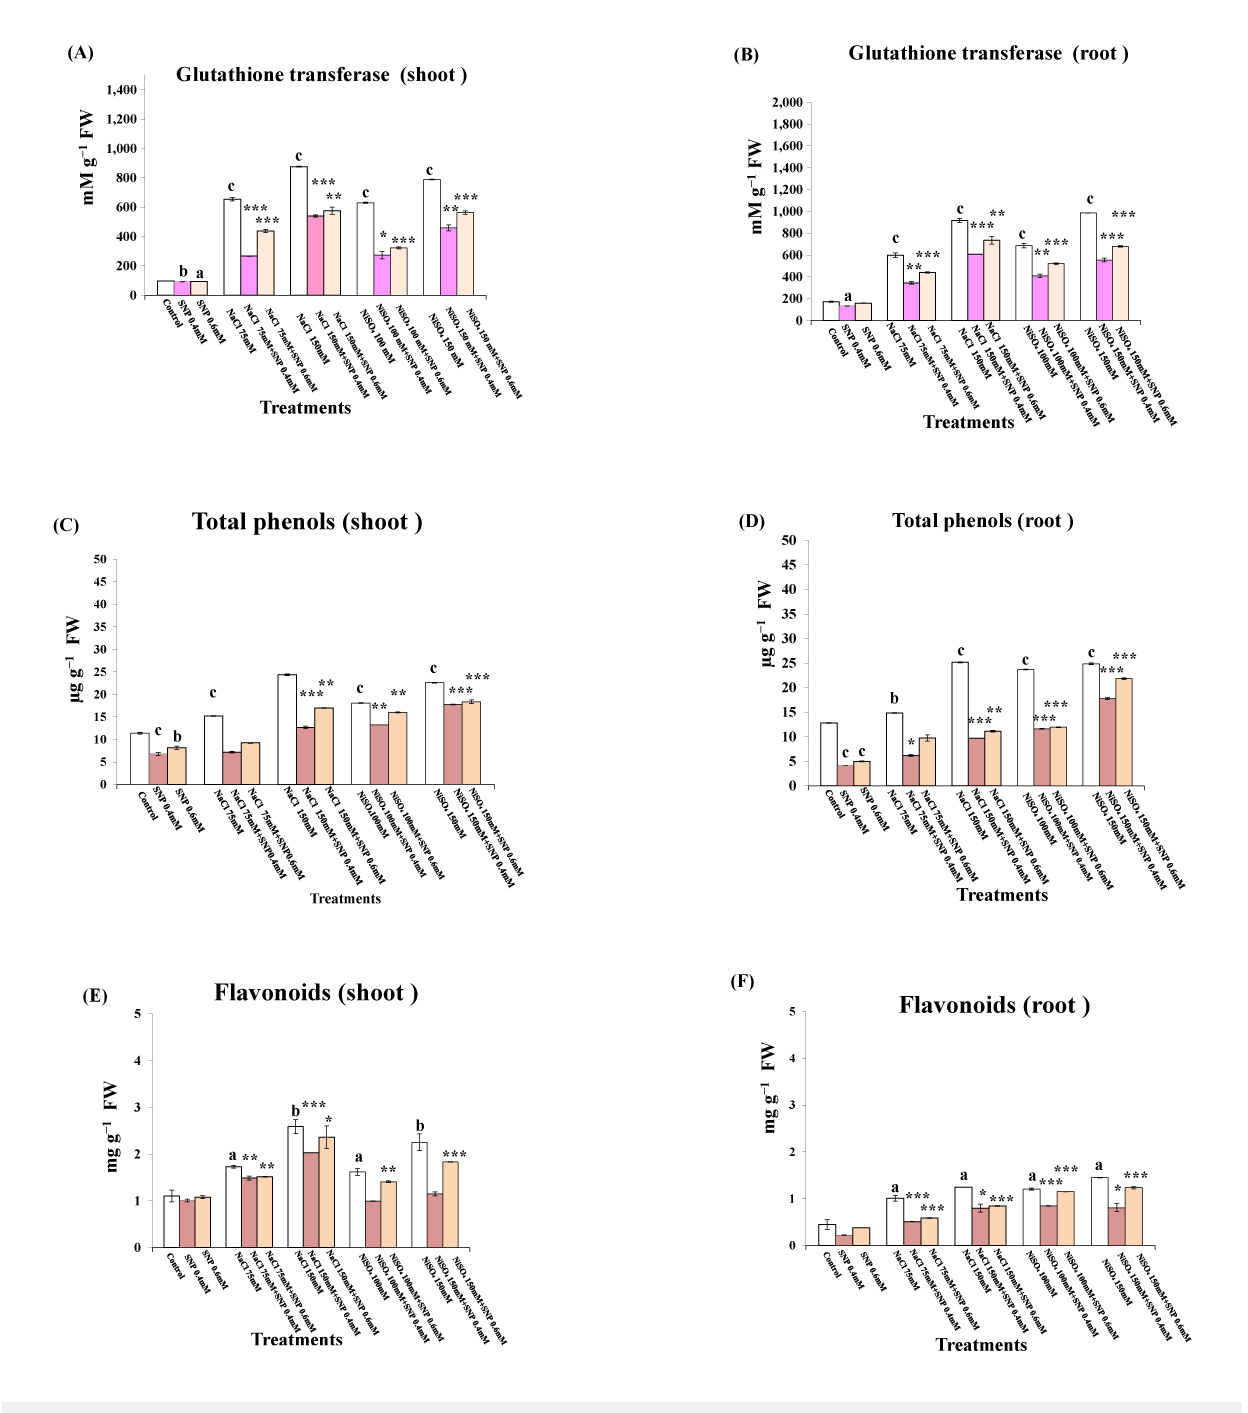
Figure 2 Effect of sodium nitroprusside (SNP) (as nitric oxide donor) on glutathione transferase activity, total phenolics and flavonoids contents of Lupinus albus subsp. termis (Forssk.) Ponert, under sodium chloride (0, 75, and 150 mM) and Ni stress (0, − 1 100, and 150 mM). The results of total phenolics and flavonoids are expressed in µ g g fresh weight. Data are mean ± SE (standard error) offive replicates. Values with letters are significantly different from the control (tap water). Letter “a” at p < 0.05 (significant), “b” at p < 0.01 (highly significant), “c” at p < 0.001 (extremely significant), and no letter = nonsignificant. Values with asterisks are significantly different from the SNP control (0.4 mM, 0.6 mM). Asterisks * at p < 0.05 (significant), ** at p < 0.01 (highly significant), *** at p < 0.001 (extremely significant), and no asterisks = nonsignificant.